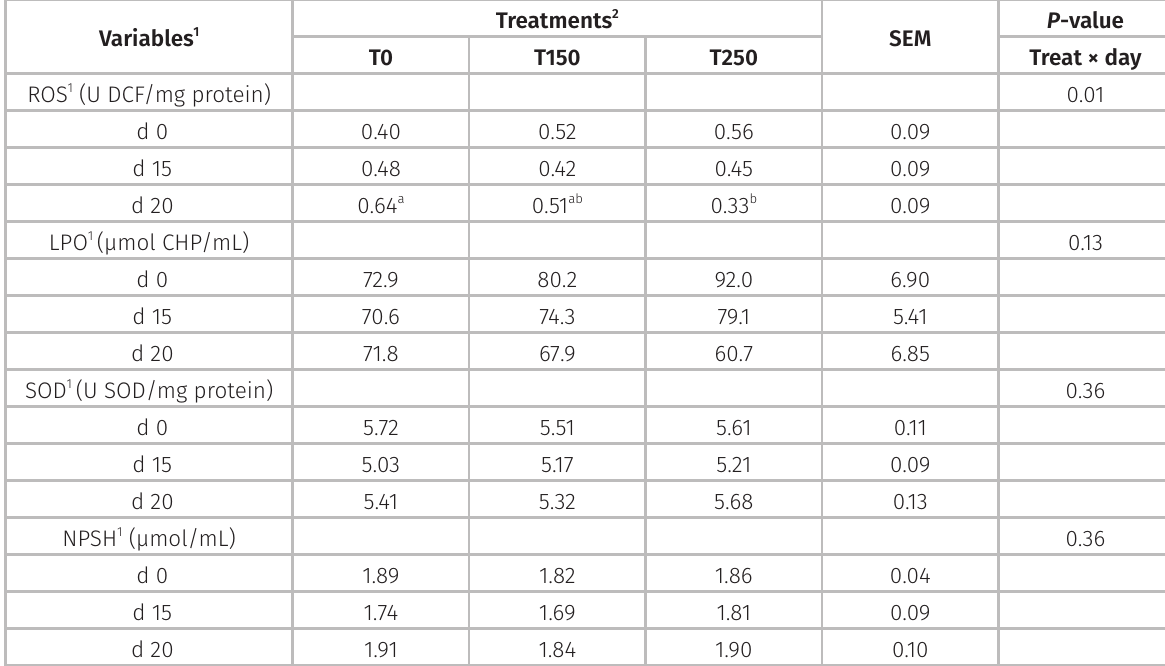
Table VI. Serum oxidants/antioxidants variables of Lacaune ewes supplemented with dietary phytogenic. Variables 1